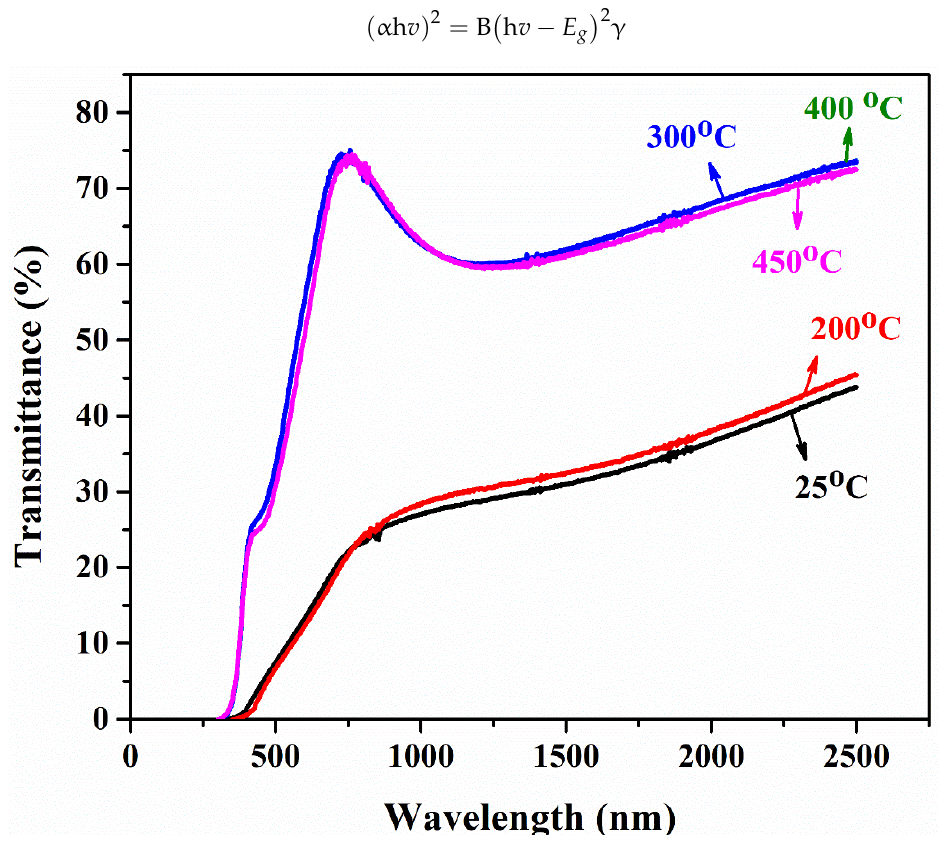
Figure 5. Transmittance spectra of PbS thin film at 25 °C, 200 °C, 300 °C, 400 °C, and 450 °C.